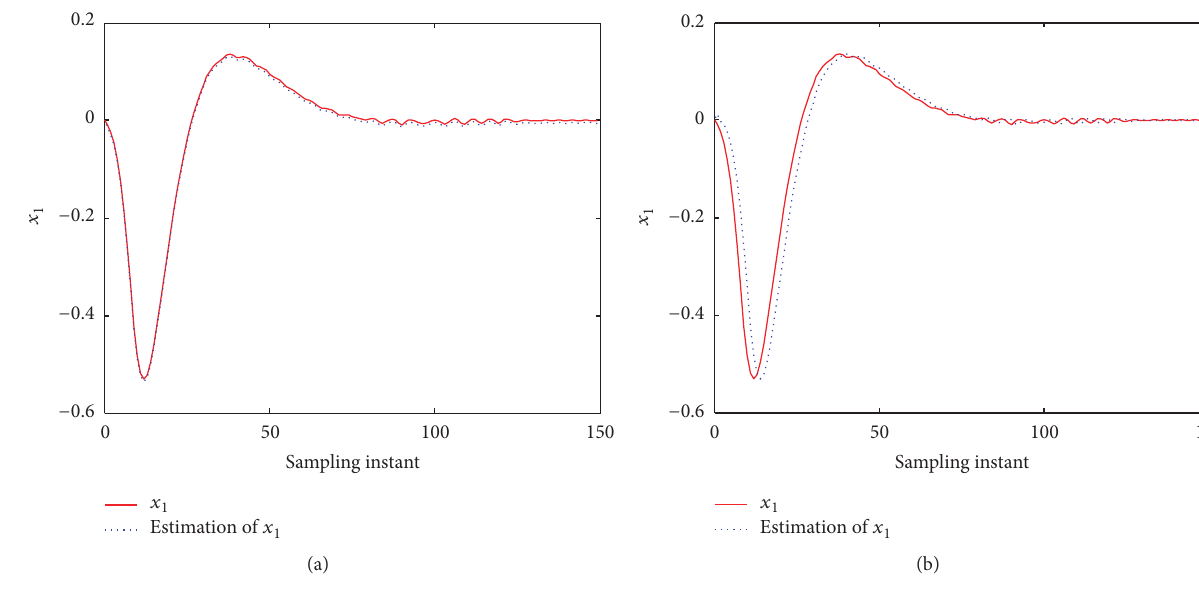
Figure 2: Comparison of 𝑥 1 and ̂𝑥 1 (a) using the NROO and (b) using the FOO.